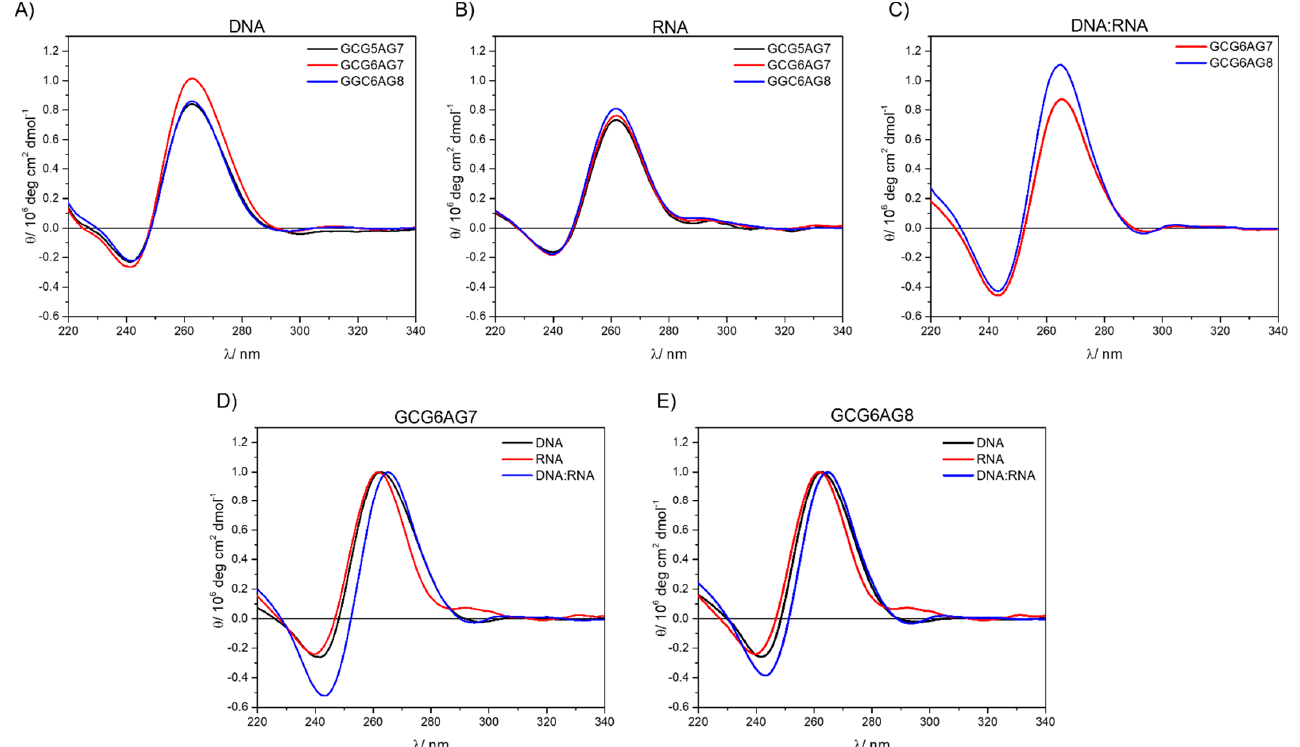
Figure 7. ( A ) CD spectra for different length DNA sequences at 230 mM K + ; ( B ) CD spectra for different length RNA sequences at 230 mM K + ; ( C ) CD spectra for different length DNA:RNA hybrids at 230 mM K + ; ( D ) normalized CD spectra of GCG6AG7, rGCG6AG7 and DNA:RNA-hGCG6AG7; ( E ) normalized CD spectra of GCG6AG8, rGCG6AG8 and